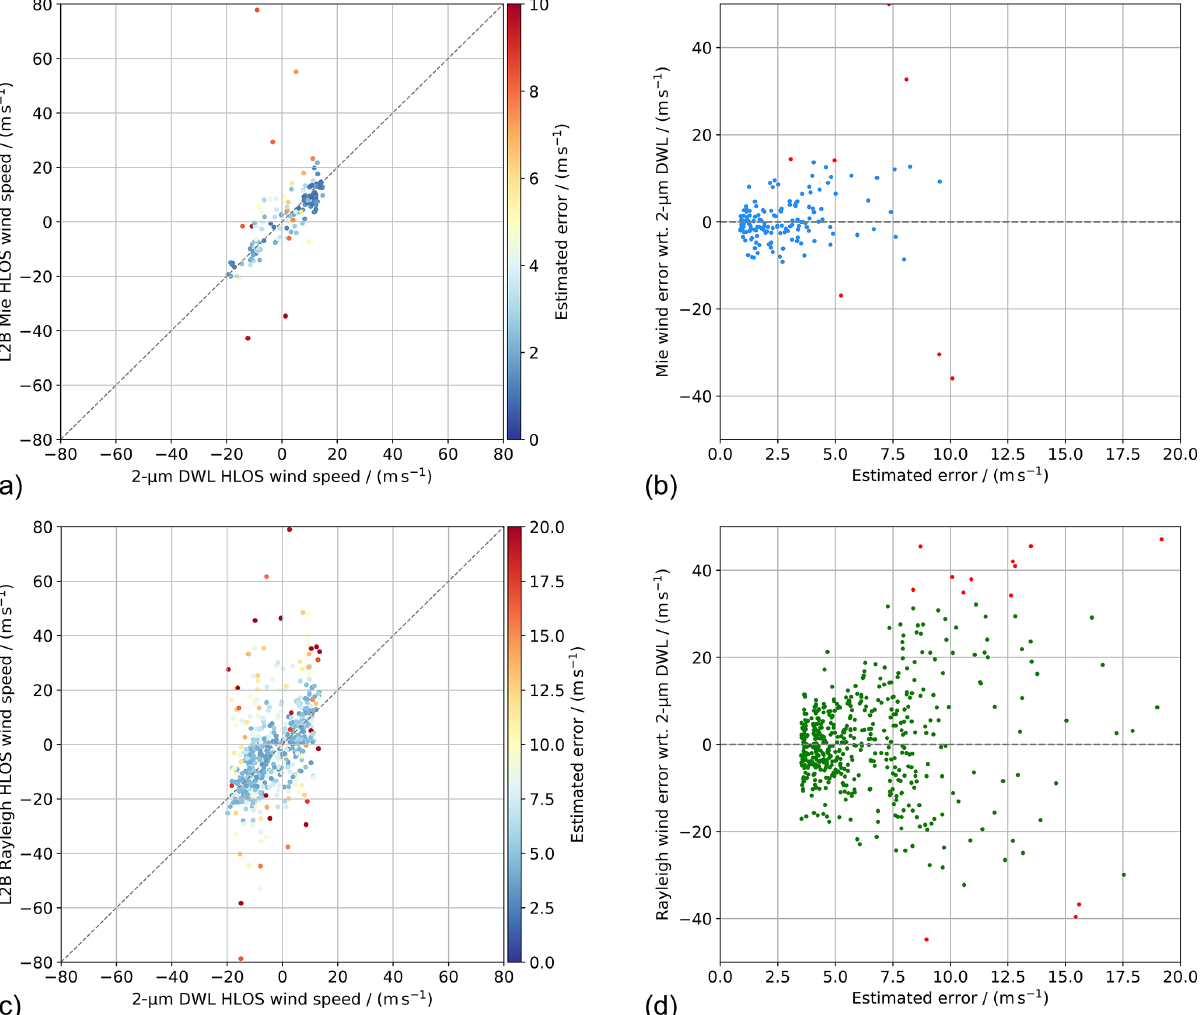
Figure 7. (a) Scatterplots comparing the L2B Mie-cloudy wind results against 2µm DWL winds (projected onto the horizontal viewing direction of Aeolus) from the 11 underflights of the AVATAR-T campaign. The colour-coding describes the L2B EE of the wind results. (b) Mie-cloudy wind error with respect to the 2µm DWL winds vs. the L2B EE. The red data points represent outliers as identified by the modified Z score ( | Z m | > 3 . 5 ) . The bottom panels (c) and (d) depict the corresponding plots for the L2B Rayleigh-clear wind